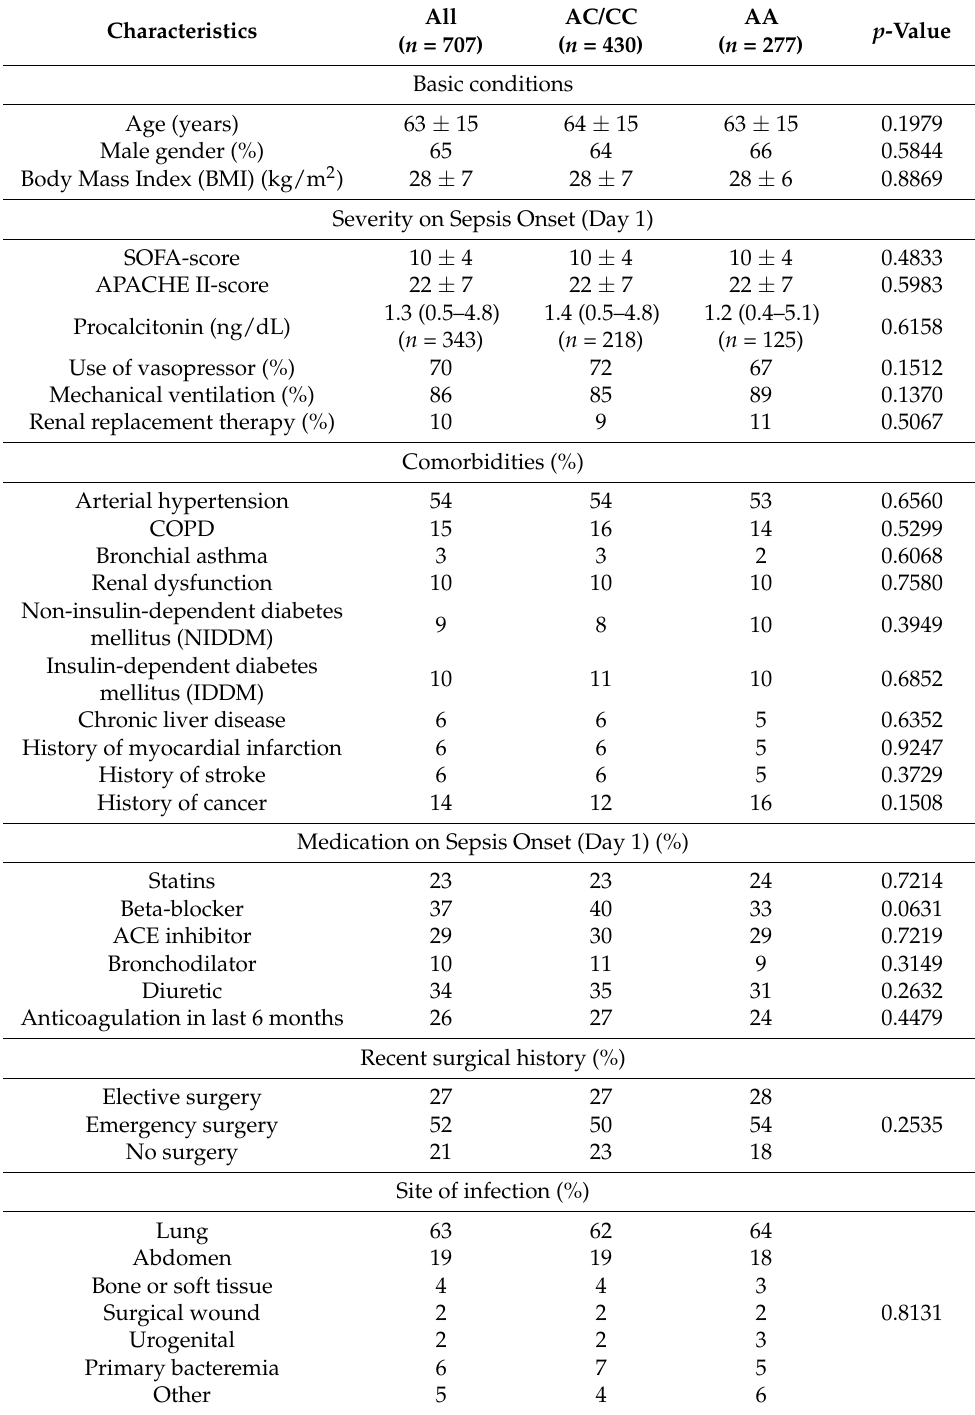
Table 1. Baseline characteristics regarding LAG-3 rs951818